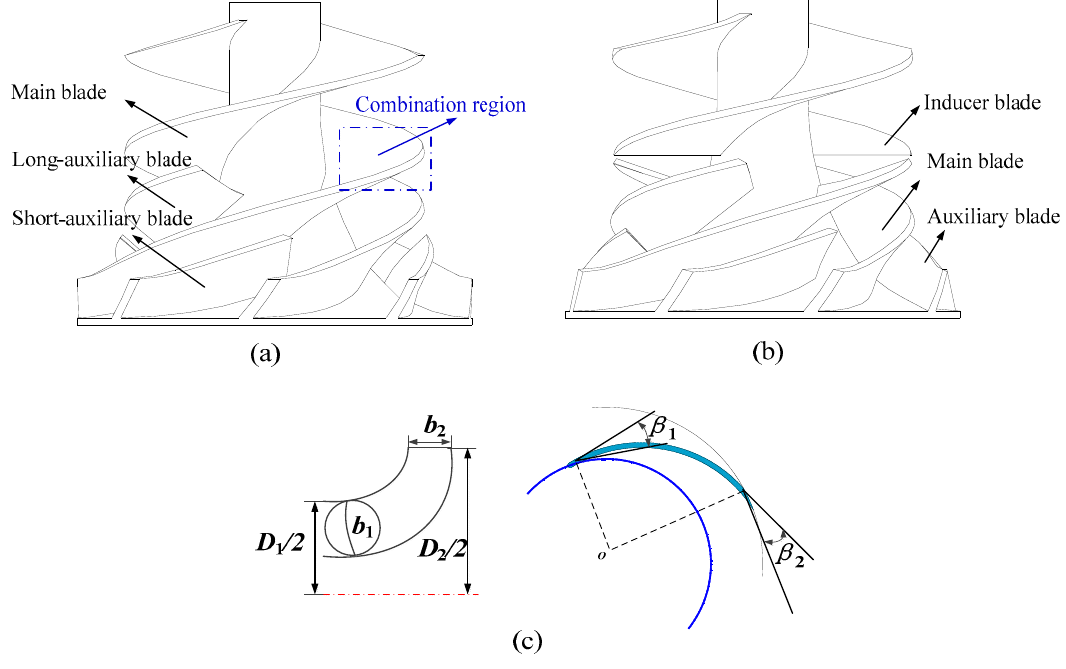
Figure 2. Shapes of combination and conventional impellers: ( a ) a combination impeller; ( b ) a conventional impeller; ( c ) the main geometrical parameters.